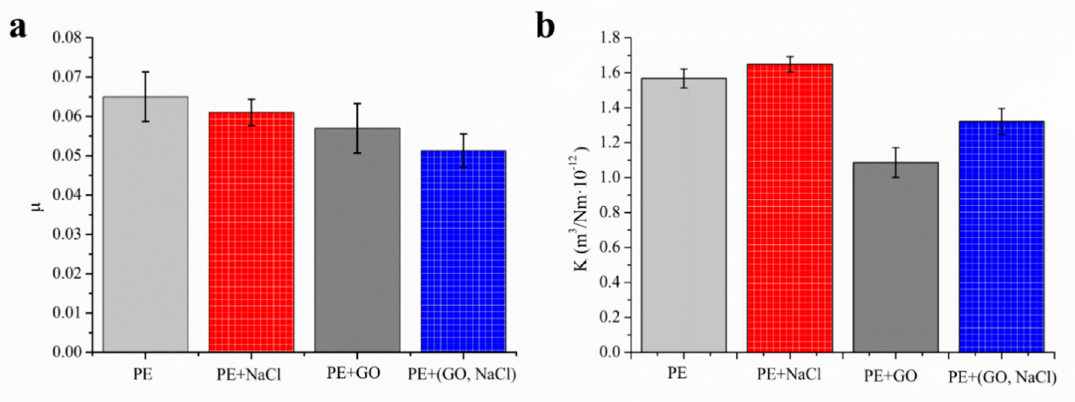
Figure 11. Coefficient of friction ( a ) and wear ratio ( b ) of UHMWPE, UHMWPE with NaCl, UHMWPE with GO, and UHMWPE with NaCl and GO.